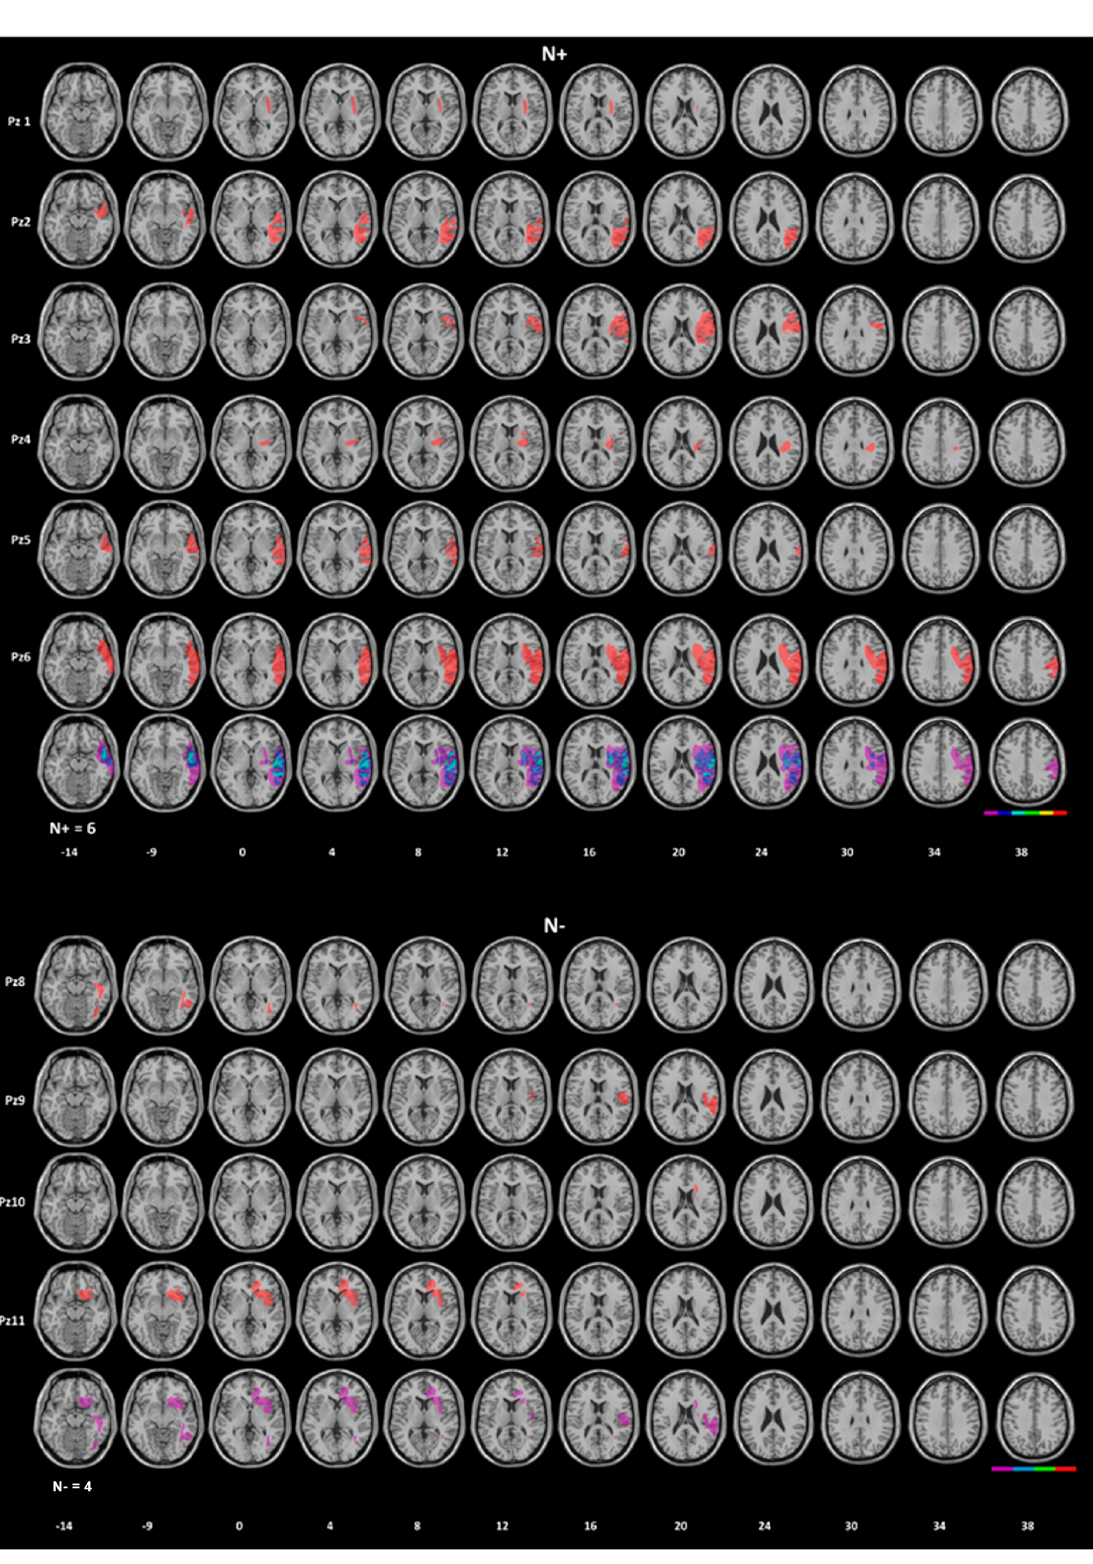
Figure 1. Lesion localization of brain-damaged patients. Top, N+ patients. Bottom, N − patients. Overlay lesion plots are shown (bottom row = frequencies of overlapping lesions, from dark violet, n = 1, to red, n = maximum 6). Lesions were drawn on standard MRI template with a 1-mm slice distance (voxels of 1 mm 3 ). The Montreal Neurological Institute (MNI) Z-coordinates of each transverse section are reported. Right brain side on the right of the images.